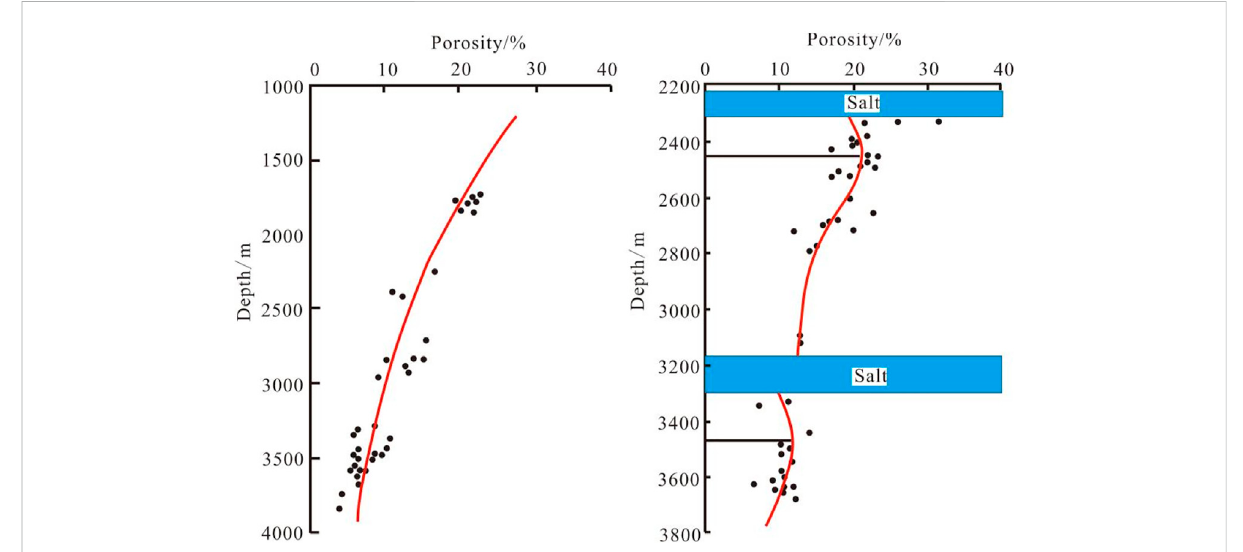
FIGURE 12 Porosity vs. depth diagram for reservoirs in different environments of Dongpu